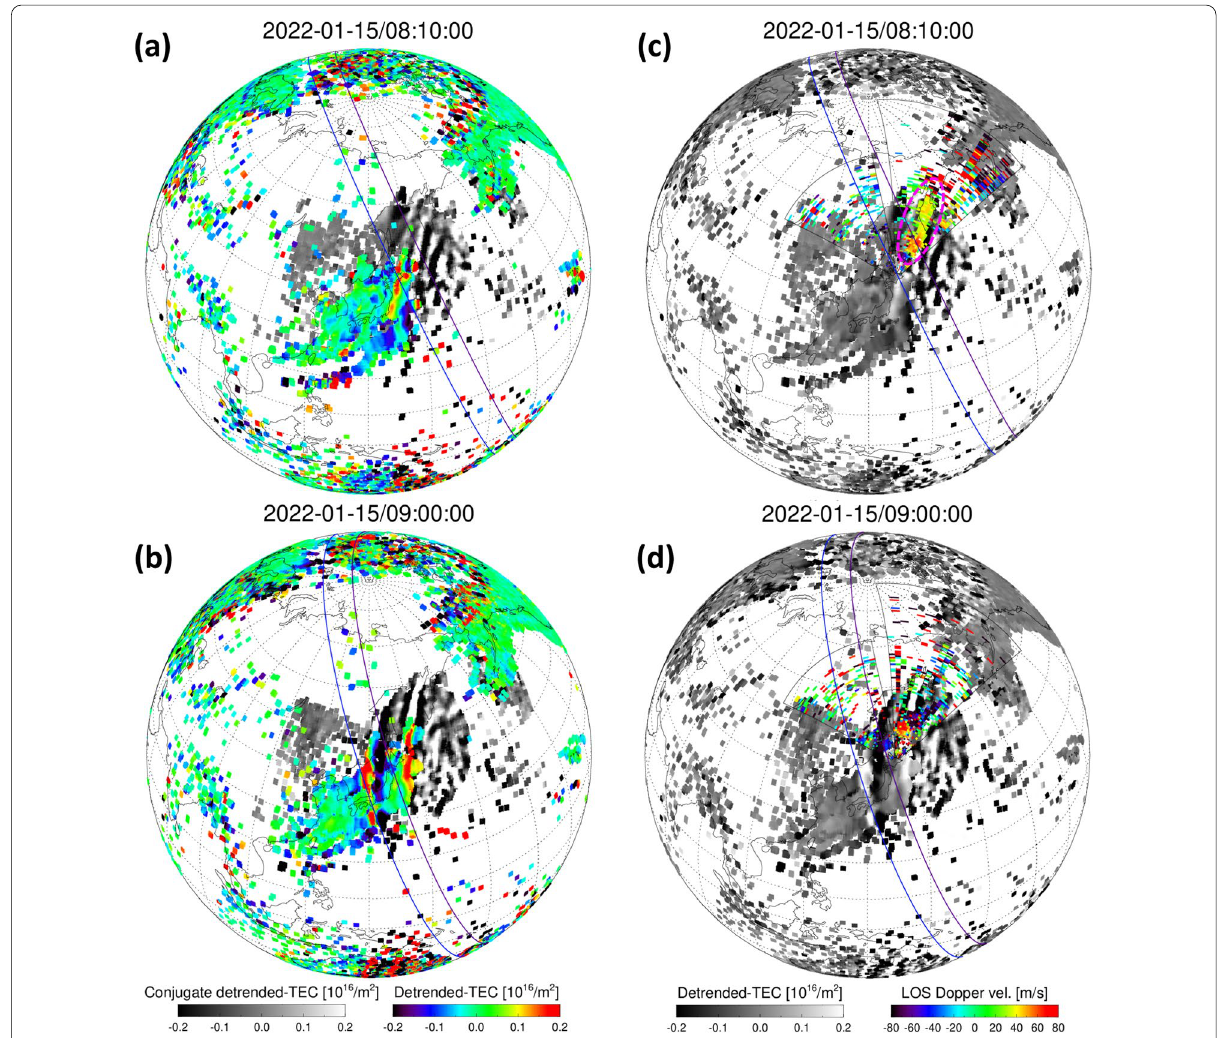
Fig. 2 Polar maps ( a ) and ( b ) of detrended TEC in geographic coordinates at 08:10 and 09:00 UT on 15 January. The detrended TEC values are indicated by two different color codes in a range of 0.2 to 0.2 TECU. The detrended TEC values expressed in the gray scale are the magnetic − conjugate detrended TEC ones in the Southern Hemisphere. Polar maps ( c ) and ( d ) of detrended TEC and line-of-site Doppler velocity in geographic coordinates. The plotted time is the same as that of panels ( a ) and ( b ). The line-of-site Doppler velocity observed by the SuperDARN Hokkaido east and west radars is shown by the right-bottom color bar in a range of 80 to 80 m/s. The blue and purple curves show the sunset terminators at − a height of 105 and 300 km, respectively. The pink dashed circle in panel ( c ) corresponds to the observed region of positive line-of-site Doppler velocity along the wavefront structure of positive TEC